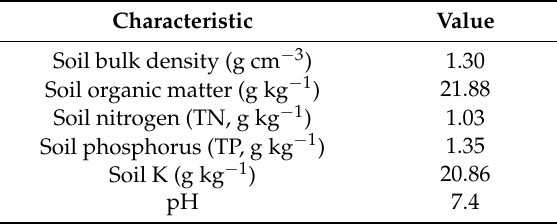
Table 1. Soil properties of the experimental